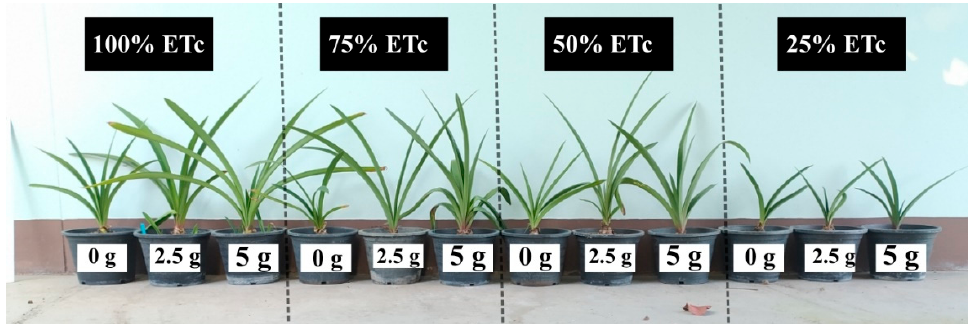
Figure 4. Plant growth of Hippeastrum ‘Red Lion’ grown under different irrigation level combinations with different fertilization rates 180 days after planting. At the bulb harvest stage (180 DAP), the results showed that the fertilizer rate factor did not affect bulb firmness, but bulb fresh weight and circumference increased when plants had higher fertilizer rates. However, a significant interaction between watering and fertilization rates was found in all bulb quality parameters. The highest bulb fresh weight (511.47 g) occurred in the treatment with 100% ETc watering and supplied with 5 g of fertilizer. However, the bulb circumference and firmness of plants supplied with 75% or 100% ETc combined with 5 g of fertilizer were not significantly different (Table 4, Figure